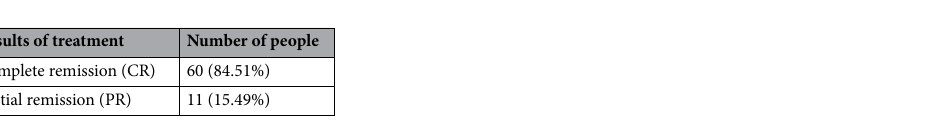
Table 2. The therapeutic effect of YSGG-PDT on OL.